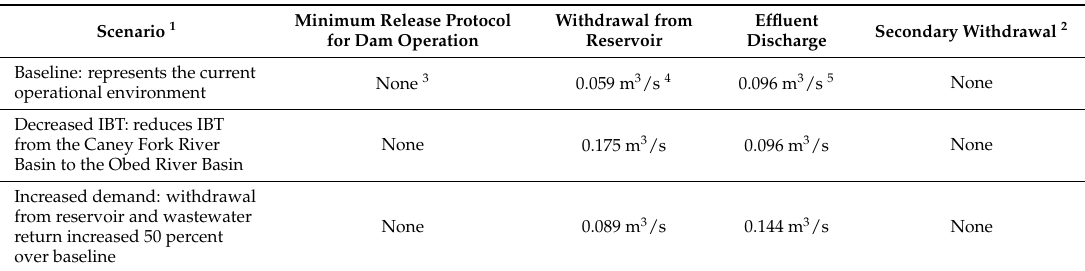
Table 1. Descriptions of water-management scenarios for defining flow alterations in the case study. (m 3 /s, cubic meters per second; IBT, inter-basin